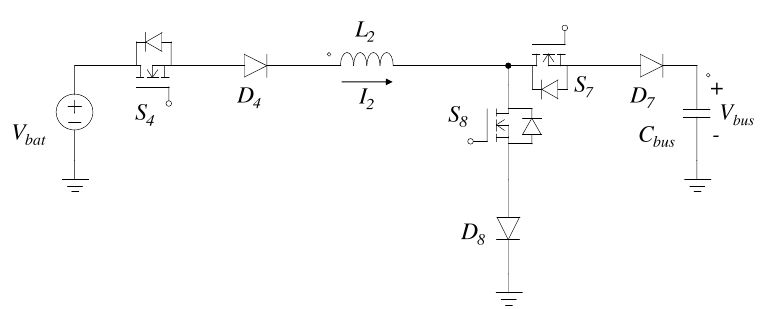
Figure 9. Circuit considered for the analysis of the